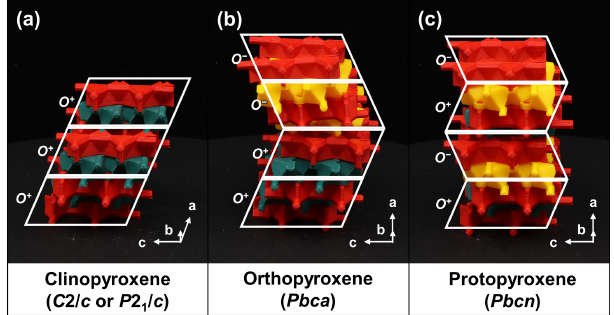
Figure 10. The relationship between polytypes and symmetry for the pyroxene group (Thompson, 1981). The O module produces a stacking offset between the T + and T − modules. (a) In the struc- ture of clinopyroxenes, the stacking offset propagates ( ++++ ), leading to monoclinic symmetry. (b) In orthopyroxenes, the stack- ing offset alternates for each corrugated layer ( ++−− ), resulting in no net offset and orthorhombic symmetry. (c) In protopyroxenes, the stacking offset alternates every layer ( +−+− ), resulting in no net offset and orthorhombic symmetry. Note the departure from Thompson’s (1981) notation; see Sect. S1.3.